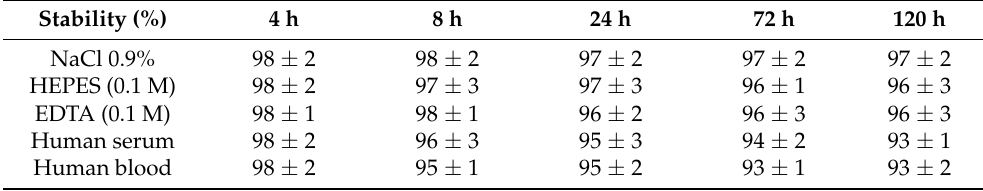
Table 2. Amount of intact [ 111 In]In-IP-001 over time in different media ( n = 3; mean ± SD). The percentages were computed by means of radio-TLC (thin-layer chromatography) or RP-HPLC analyses. HEPES: 4-(2-hydroxyethyl)-1-piperazineethanesulfonic acid. Stability (%) 4 h 8 h 24 h 72 h 120 h NaCl 0.9% 98 ± 2 98 ± 2 97 ± 2 97 ± 2 97 ± 2 HEPES (0.1 M) 98 ± 2 97 ± 3 EDTA (0.1 M) Human serum 93 ± 1 Human blood 98 ± 2 95 ± 1 95 ± 2 93 ± 1 93 ±